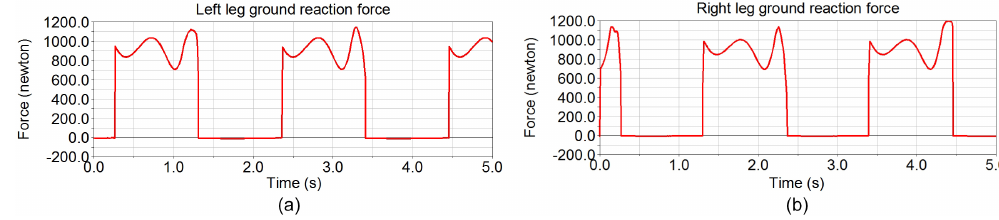
Figure 21. Computed exoskeleton ground reaction forces (GRF): (a) for left leg; (b) for right leg.